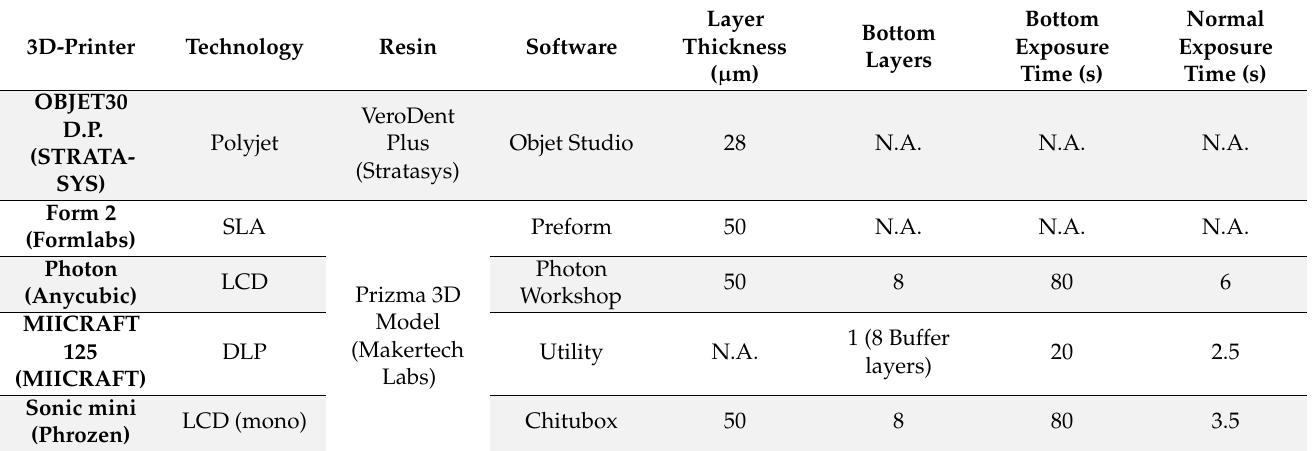
Table 1. Parameters of each 3D resin printer